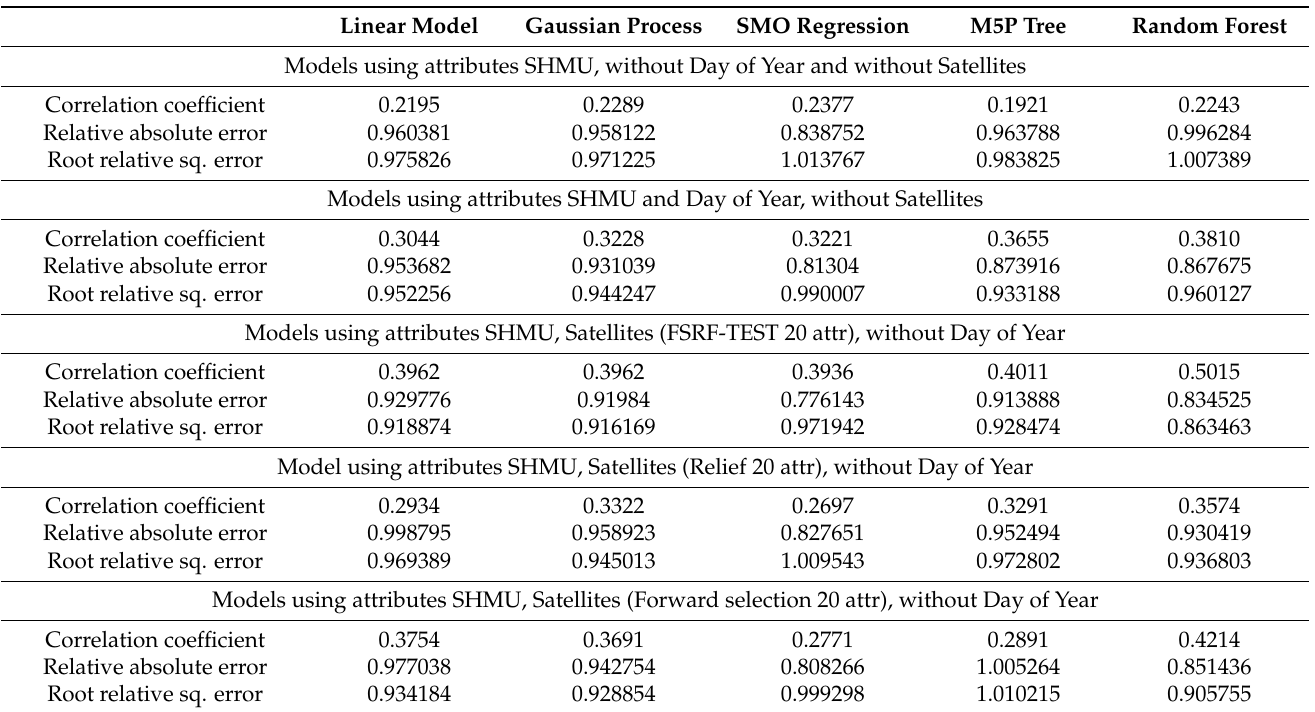
Table 2. Overview of trained regression models and their accuracy metrics for the field-measured values of target variable S (total